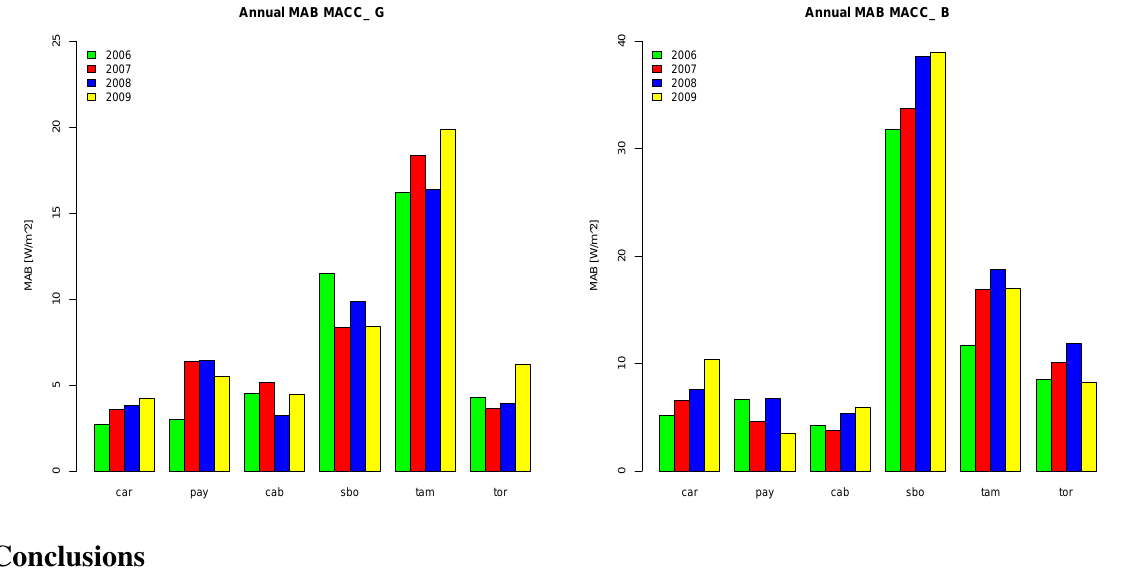
Mean Absolute Bias (mean absolute difference) using MACC for different years (colored bars) at six Baseline Surface Radiation Network (BSRN) stations for global irradiance (G, left ) and direct irradiance (B, right